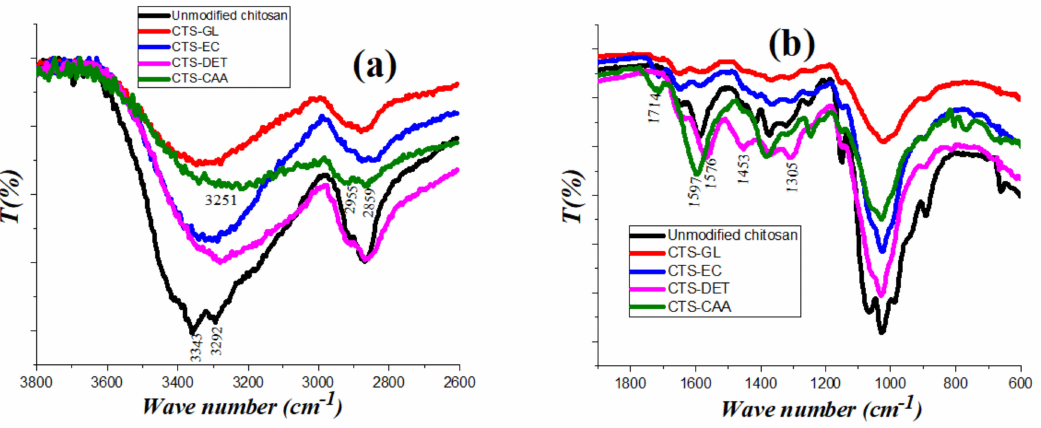
Figure 1. FT-IR spectra of (unmodified chitosan), (CTS-GL), (CTS-EC), (CTS-DET), and (CTS-CAA) [wavenumber range limited to 3800–2600 cm − 1 ] ( a ), [wavenumber range limited to 1900–600 cm − 1 ] ( b ). As displayed in SEM images (Figure 2), the chitosan modification with carboxyl groups (CTS-CAA) affected the surface morphology of the biopolymer.